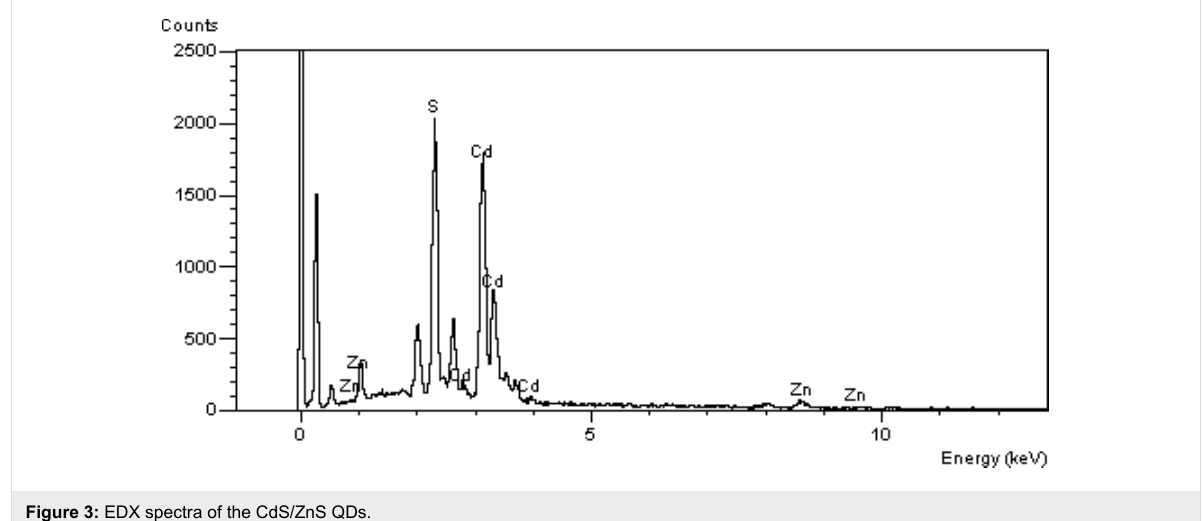
Figure 3: EDX spectra of the CdS/ZnS QDs.